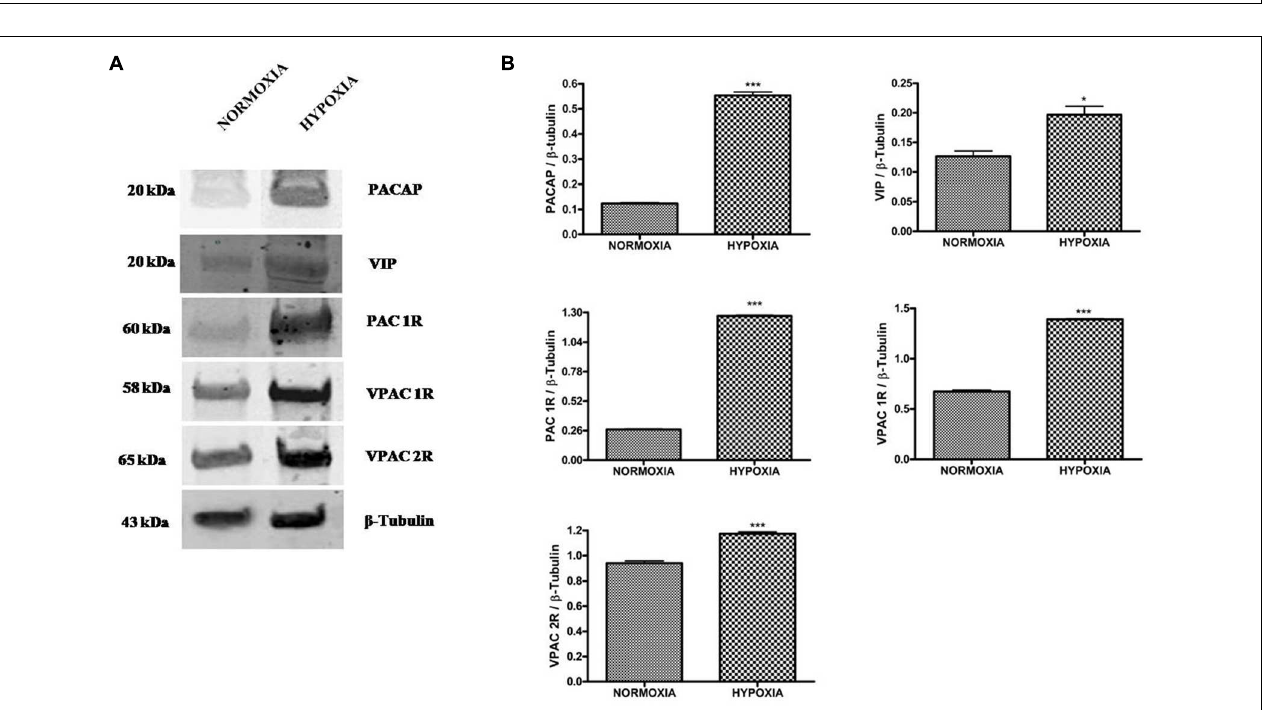
FIGURE 2 | Expression of PACAP, VIP, PAC1R, VPAC1R, and VPAC2R in glioblastoma cells under normoxic or hypoxic conditions. (A) Representative immunoblot of PACAP and VIP precursor peptides and PAC1R, VPAC1R, and VPAC2R expression on U87MG cells grown normoxia or exposed to hypoxia. (B) The bar graphs show quantitative analysis of signals obtained on immunoblots resulting from three independent experiments. Relative band densities were quantified by using ImageJ software. Protein levels are expressed as arbitrary units obtained after normalization to β -tubulin which was used as loading control. Data represent means ± SEM ( ∗ p < 0.05 or ∗∗∗ p < 0.001 vs. Normoxia as determined by unpaired two-tailed Student t -test).